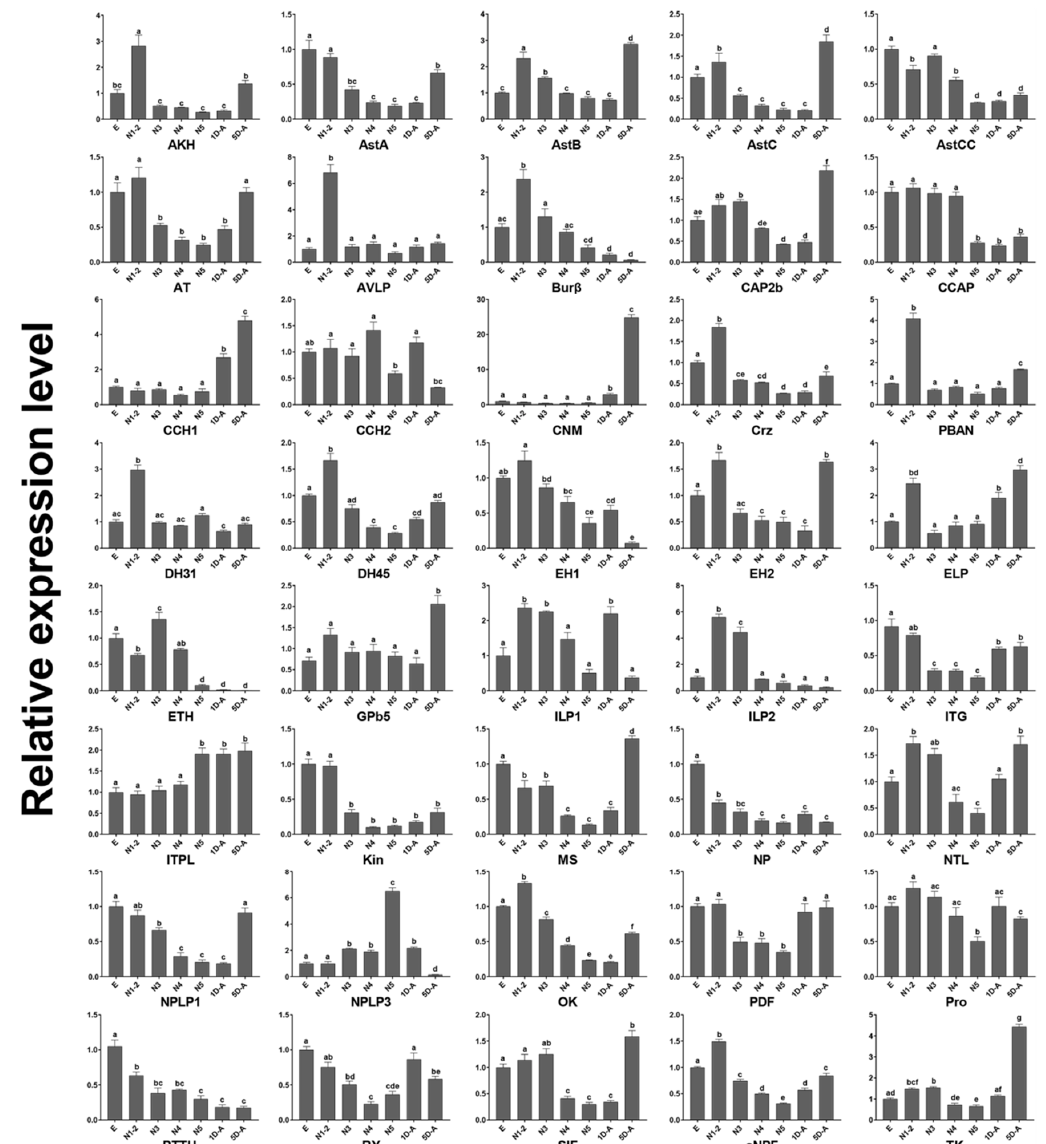
Figure 7. qRT-PCR results of neuropeptides throughout the D. citri life cycle. The y -axis represents the relative expression level and the x -axis the life cycle. The standard error is represented by the error bar and significant differences are represented by the different letters ( p < 0.05). E, egg; N1-2, 1st- and 2nd-instar nymphs; N3, 3rd instar nymphs; N4, 4th instar nymphs; N5, 5th instar nymphs; 1D-A, the adults of one day after eclosion; 5D-A, five days after eclosion.